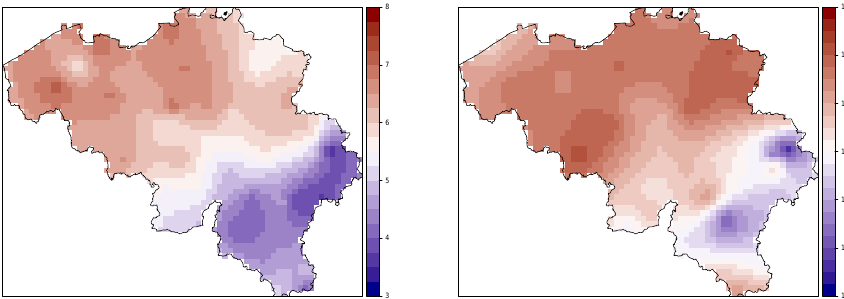
Figure 2. Averaged temperature over the 34 years [ ◦ C] for TN (left panel) and TX (right panels) using reference station records only. The interpolation was made using ordinary kriging method (see Sect. 3). The missing data are estimated by spatial